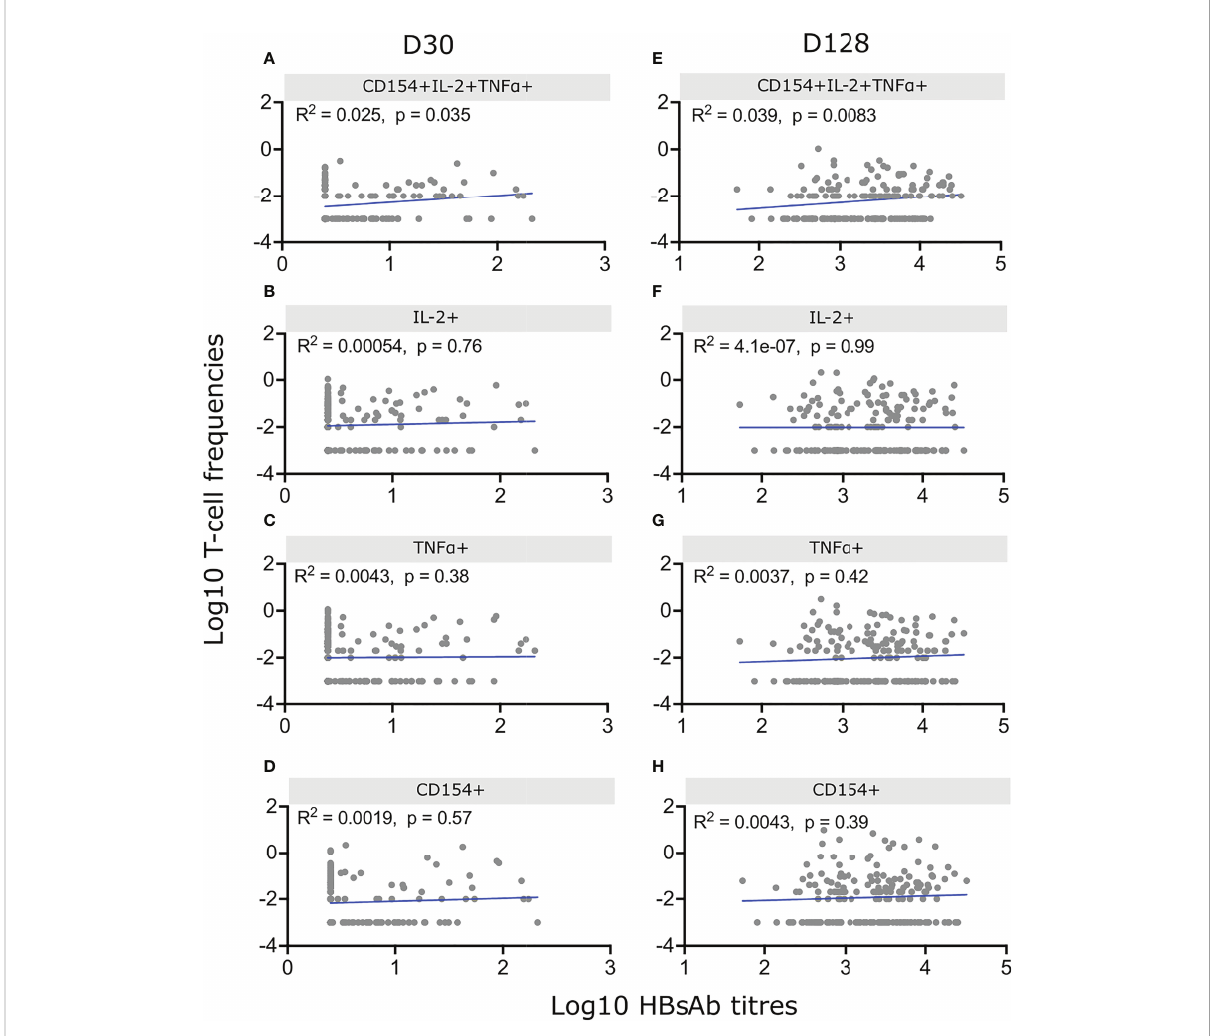
FIGURE 4 Correlation between HepB speci fi c CD4 + T-cells and antibody titres. Infants were vaccinated with HepB in the fi rst week of life and received additional doses at 6, 10 and 14 weeks. IgG1 antibodies were measured at D30 and D128 and PBMCs from the same blood draws were stimulated with HBsAg for 18hrs and stained as in Figures 2, 3. Cell frequencies of CD4 + polyfunctional T-cells (A, E) or frequencies based on total expression of IL-2 (B, F) , TNF a (C, G) or CD154 (D, H) were correlated with their matched antibody titres on D30 (A – D) or D128 (E – H) . Background CD4 + T-cell activation was removed by subtracting values from unstimulated matched samples. Only infants with undetectable HepB-speci fi c antibody titres at birth and available matched Ab – T-cell sample (n = 179) were included. Spearman correlation was performed on Log10 of CD4 + T-cell frequencies and Log10 of antibody titres. P < 0,05 was considered signi fi